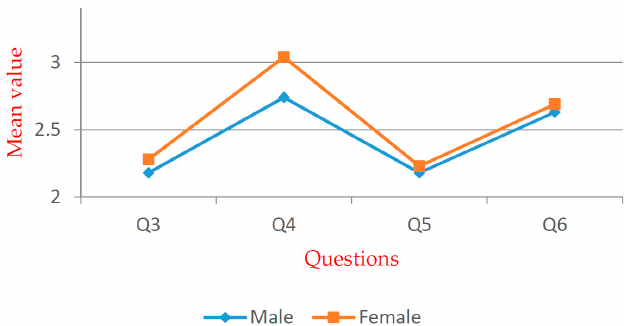
Int. J. Environ. Res. Public Health 2019 , 16 , x Figure 6. Mean values of “gender” group. Figure 6. Mean values of “gender” group. Figure 6. Mean values of “gender” group.